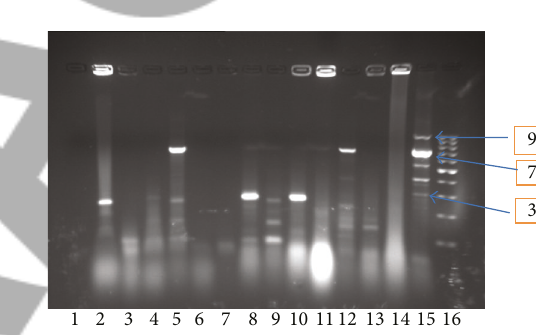
Figure 1: Results of multiplex PCR with primers specific for P. aeruginosa species,Integron1,andMetallo- 𝛽 -lactamasesgene,for13 incubator samples. Line 16 is 100–1000 bp ladder. Line 15 is positive control ( P. aeruginosa type strain ATCC 27853). Lines 5 and 12 are positive samples for P. aeruginosa (720 bp specific bands). Lines 2, 5, 8, and 10 are positive samples for Metallo- 𝛽 -lactamases gene (310 bp). All samples are negative for Integrin 1. Lines 3, 4, 6, 7, 11, 13, and 14 are negative samples and line 1 is negative control